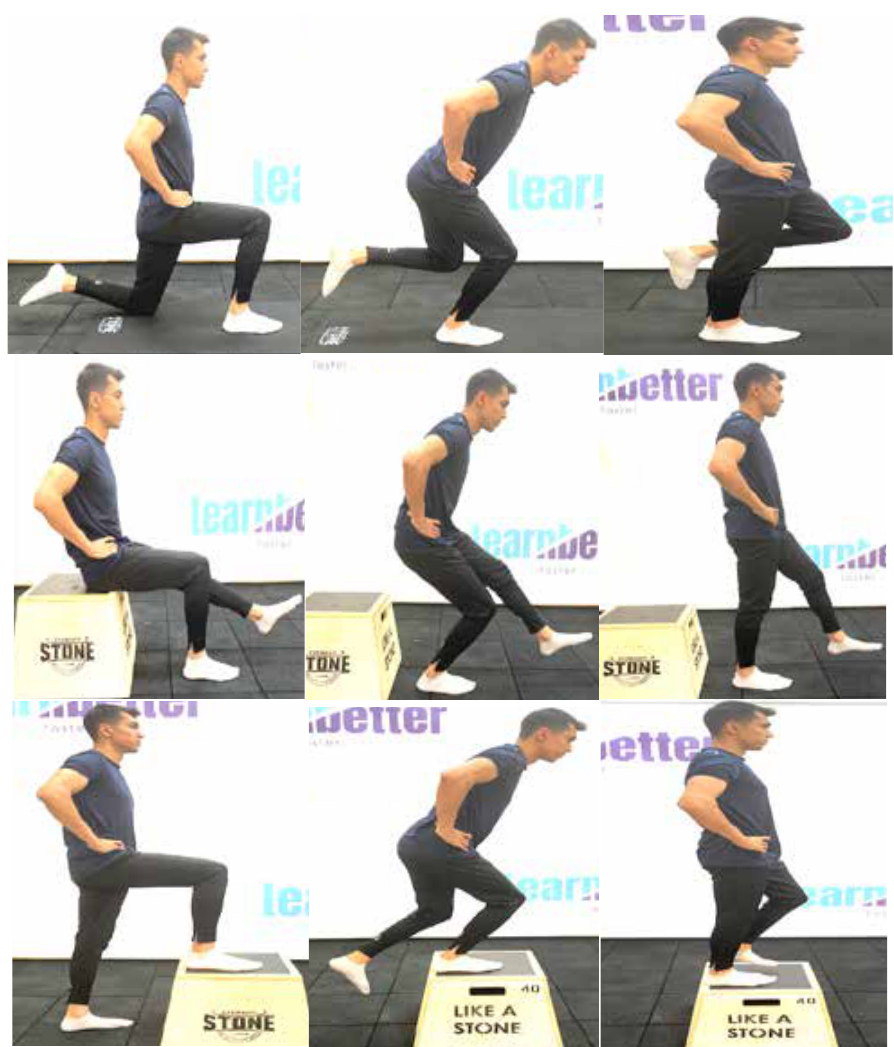
Figure 1. The beginning, middle and ending phases of exercises A) Airborne Lunge ; B) Bench Squat ; C) Table 1. The mean RMS (μV) values in the ascending phase during exercises Muscles